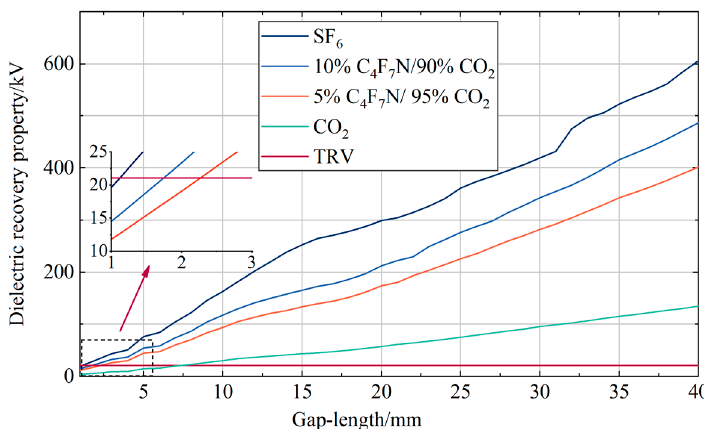
Figure 9. Dielectric recovery characteristics.